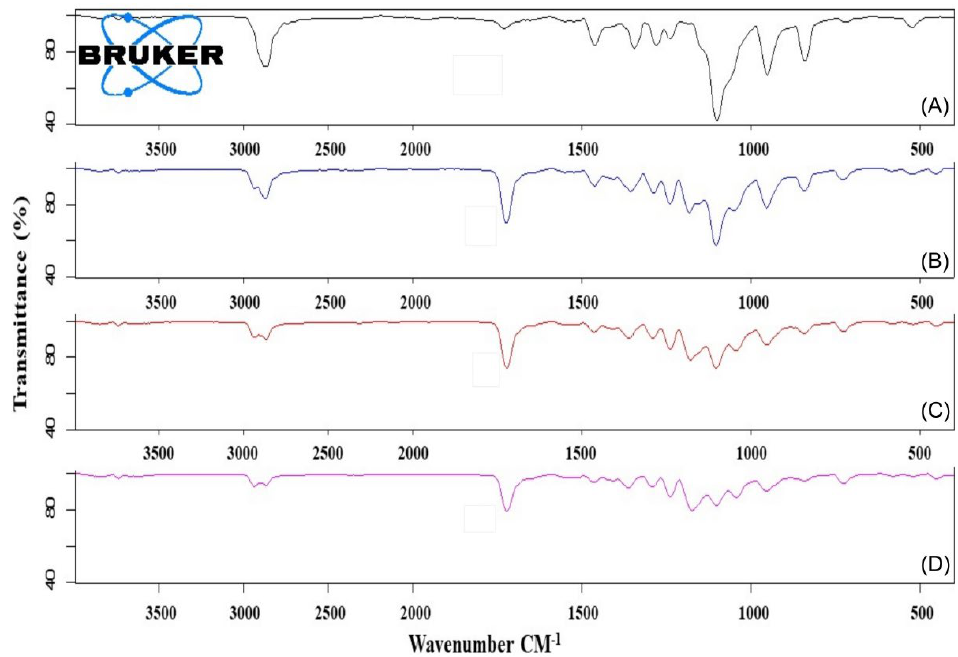
Figure 4. FTIR spectra of Myrj S100 ( A ), Myrj S100- b -PCL 44 ( B ), Myrj S100- b -PCL 88 ( C ), and Myrj S100- b -PCL 131 ( D ).